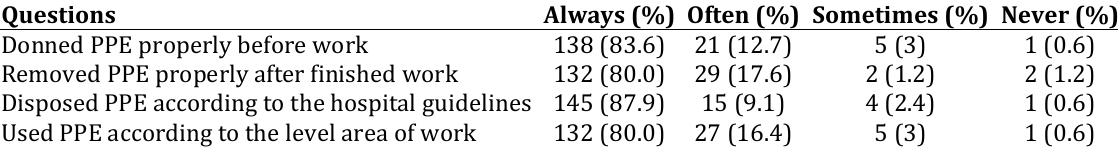
Table II. Compliance in using personal protective equipment Questions